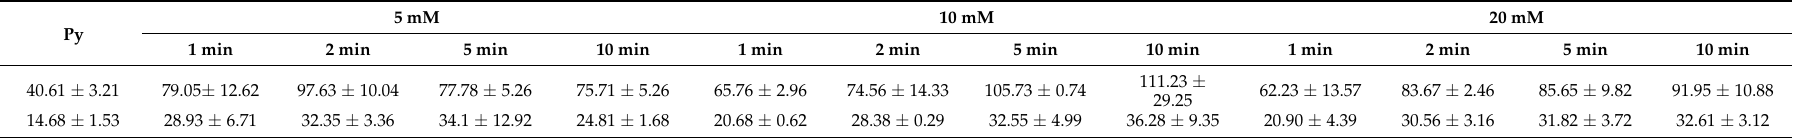
Table 2. Areas obtained in the IR spectra of the 1 nM pyridine solution on the twelve synthesized